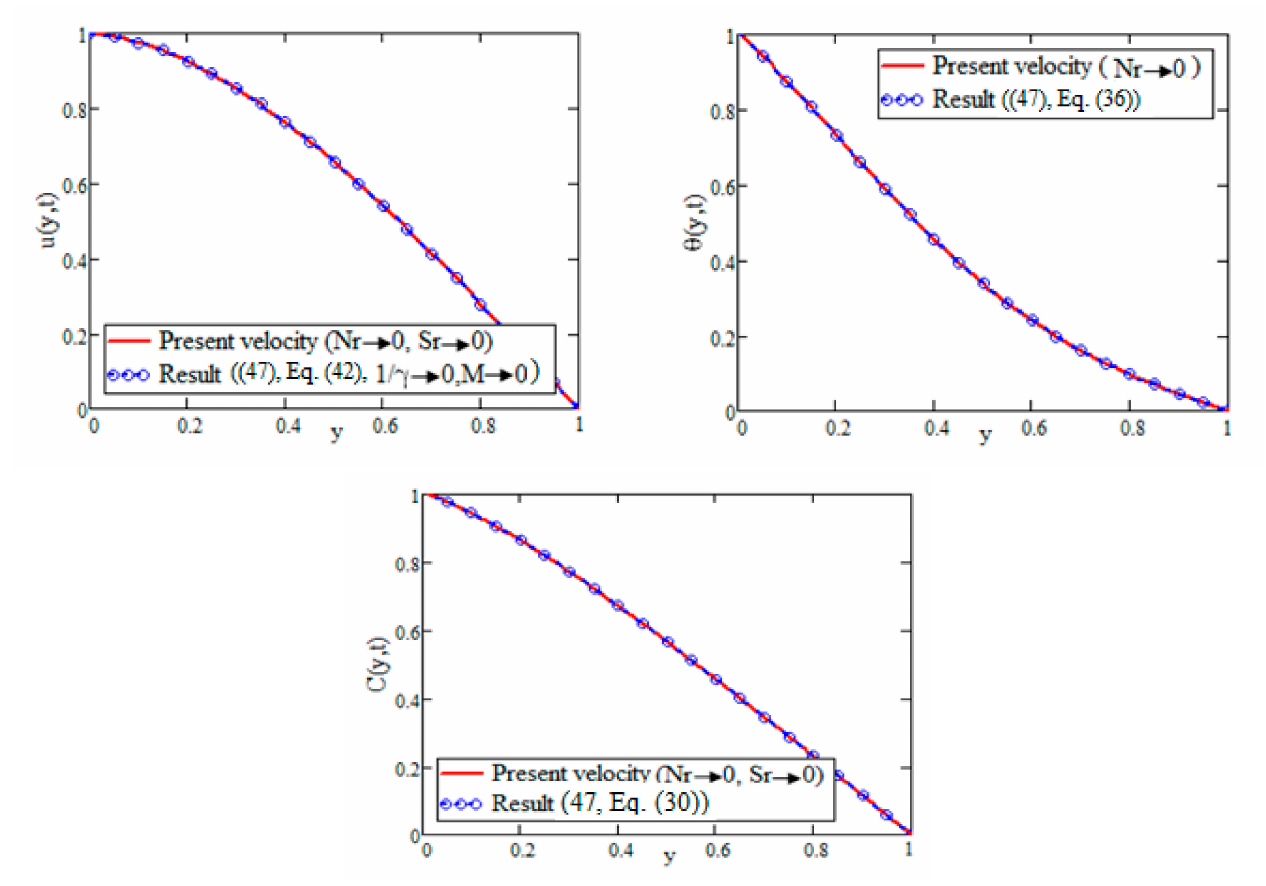
Figure 6. Comparison of results at t = 1.2. Table 3. Deviation of Nusselt numbers for various values of ϕ